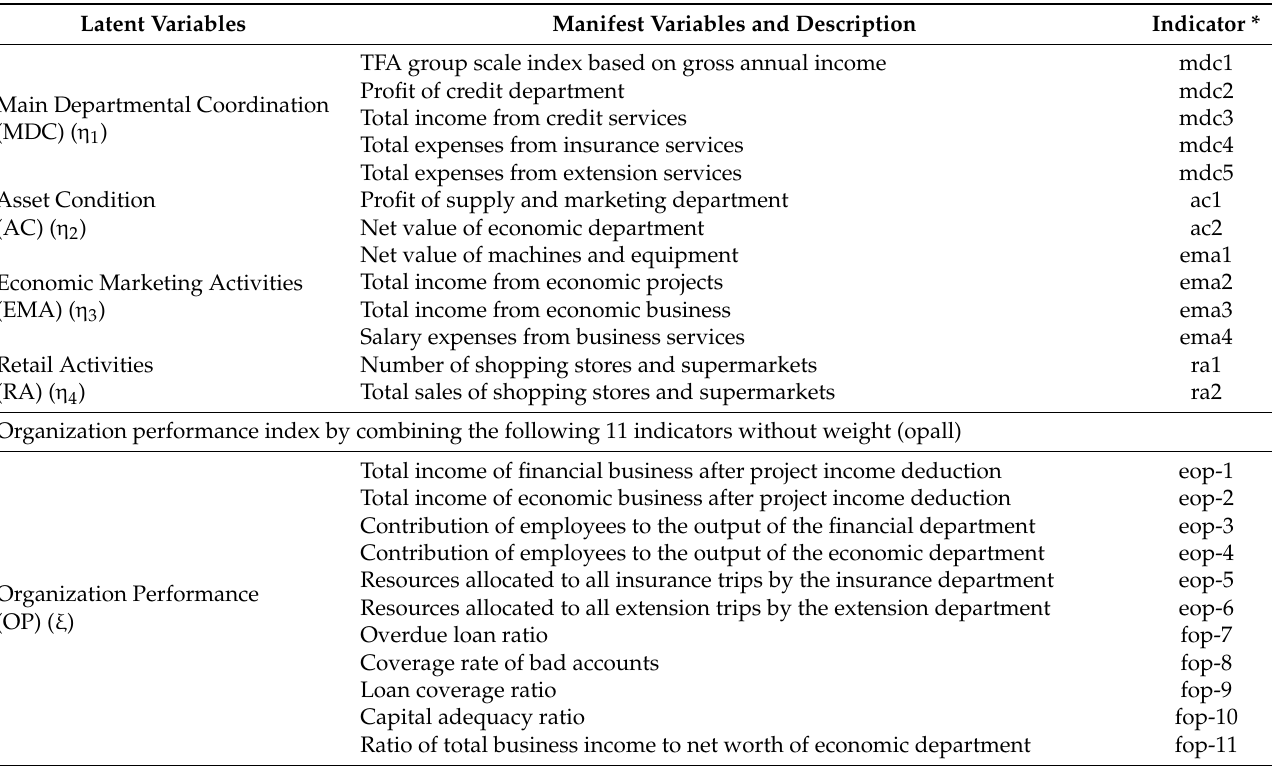
Table 1. Main components and variable indicators.